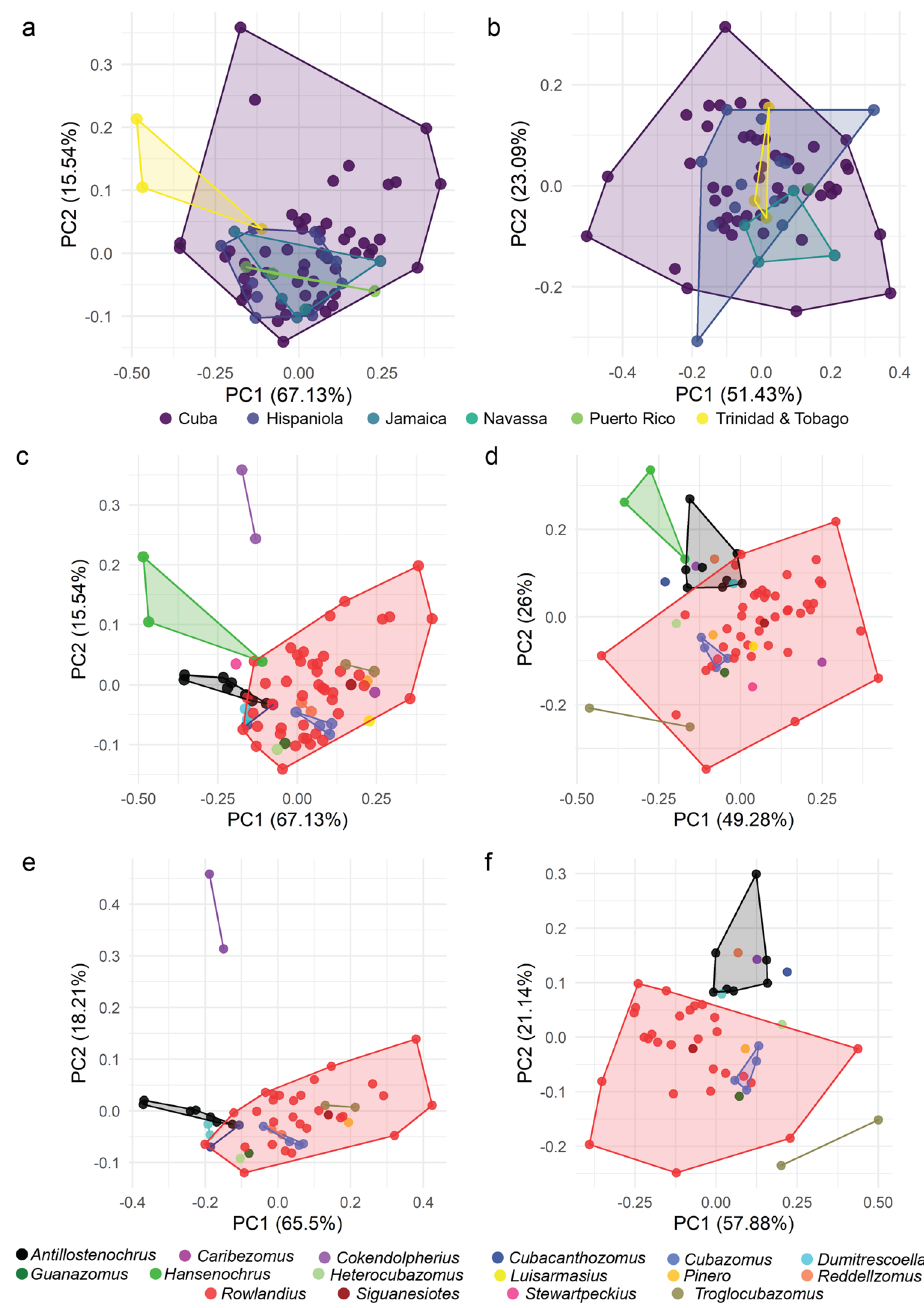
Figure 5. Morphospace plots based on male schizomid flagella of Caribbean and Cuban species. ( a ) Dorsal, by island. ( b ) Lateral, by island. ( c ) Dorsal, by genus, from Caribbean islands. ( d ) Lateral, by genus, from Caribbean islands. ( e ) Dorsal, by genus, from Cuba. ( f ) Lateral, by genus, from